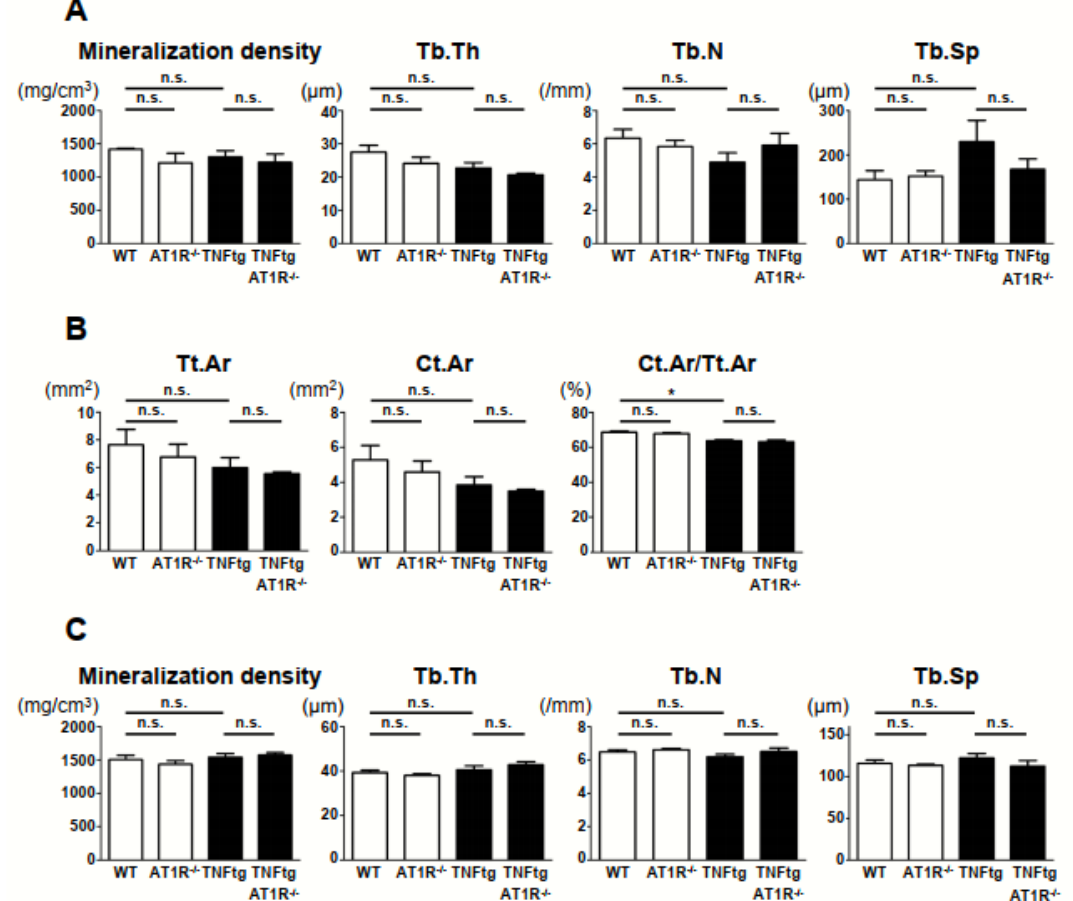
Figure A4. Trabecular and cortical bone parameters of the tibia and spine. Tumor necrosis factor-transgenic (TNFtg) mice were crossed with AT1R-deficient (AT1R − / − ) mice. Wild-type (WT; n = 9), AT1R − / − ( n = 7), TNFtg ( n = 12), and TNFtg AT1R − / − ( n = 8) male mice were analyzed at the age of 16 weeks. ( A ) Trabecular bone parameters of the tibia. ( B ) Cortical bone parameters of the tibia midshaft. ( C ) Trabecular bone parameters of the spine (fifth lumbar vertebra). Tb.Th, trabecular thickness; Tb.N, trabecular number; Tb.Sp, trabecular separation; Tt.Ar, total cross-sectional area inside the periosteal envelope; Ct.Ar, cortical cross-sectional area. Values are the mean ± SEM. n.s., not significant. *, p < 0.05.